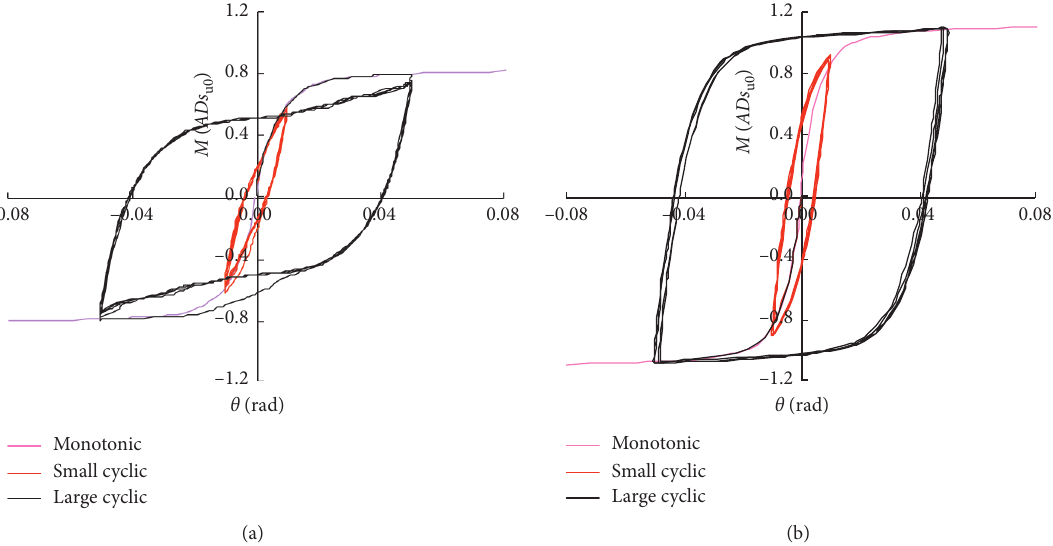
Figure 5: Relation of moment and rotation of bucket foundation of aspect ratio L / D � 0.2. (a) Imperfect interface. (b) Full